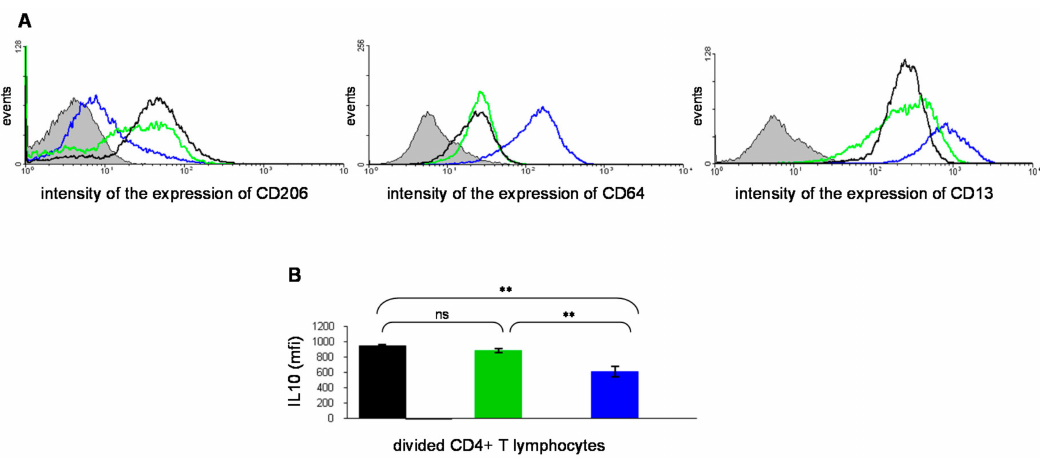
Figure 4. ( A ) Flow cytometry analysis of the phenotype of human monocytes activated in vitro by the ABP dendrimer (black line) compared to M2 (green line) and M1 monocytes (blue line). Left graph: surface expression of CD206 (the mannose receptor MRC1), which is an anti-inflammatory marker; central graph: surface expression of CD64 (a Fc γ RI receptor), an inflammatory marker; right graph: surface expression of CD13 (the aminopeptidase N), an inflammatory marker. In grey, the negative control of each surface marker (see [22]). ( B ) Flow cytometry quantification (as mean intensity fluorescence, mfi, ± SD) of intracellular IL10 in CD4+ T lymphocytes induced by human monocytes activated by the ABP dendrimer (black bar), by M2 monocytes (green bar) and by M1 monocytes (blue bar) in in vitro co-cultures. ** p < 0.001, one-way ANOVA. (see [22]). Reproduced